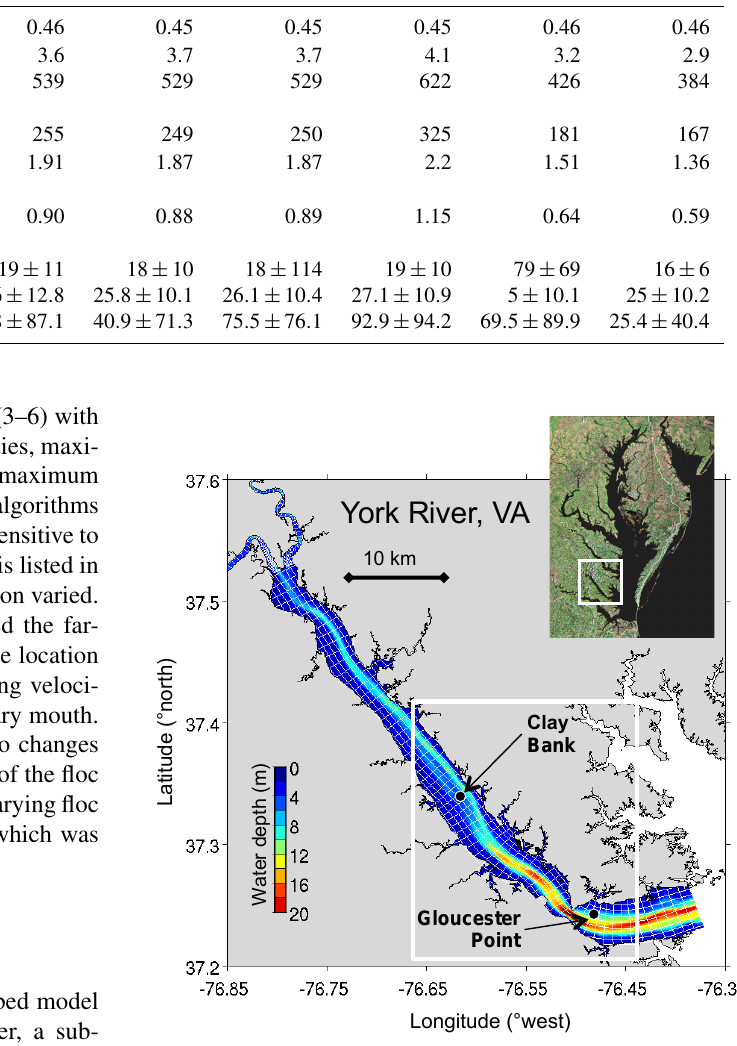
Figure 9. York River bathymetry (color scale) and model grid (white lines show every fifth grid line in the along- and across- channel directions). The inset satellite image shows the location of the York River in Chesapeake Bay. The region outlined in white is expanded in Fig.